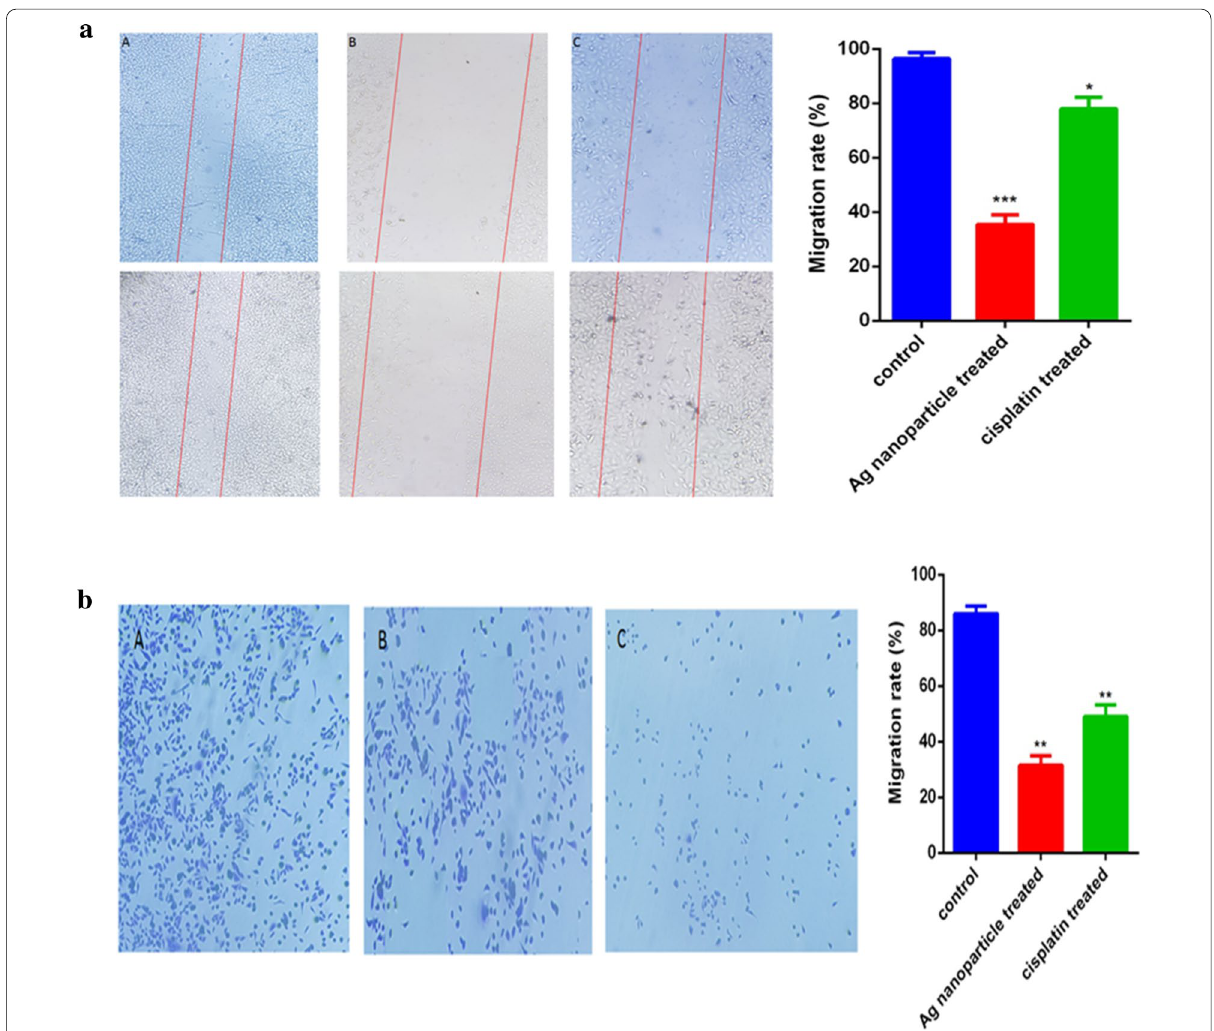
Fig. 8 a Inhibition of A549 lung cancer cell lines migration in an “in vitro wound-healing” assay. a untreated control cells, b AgNPs-treated cells, and c cisplatin-treated cells. The bar chart shows the number of migrated cells per field The results were obtained from triplicate experiments and are presented as mean standard deviation (n 3). (*P < 0.05, and ***P < 0.00). b AgNPs and cisplatin reduced cell mobility. the invasion rate ( a ) ± = in control cells, ( b ) cisplatin-treated A549 cells, and ( c ) AgNPs-treated A549 cells. The results were obtained from triplicate experiments and are presented as mean standard deviation (n 3). **p < ± =